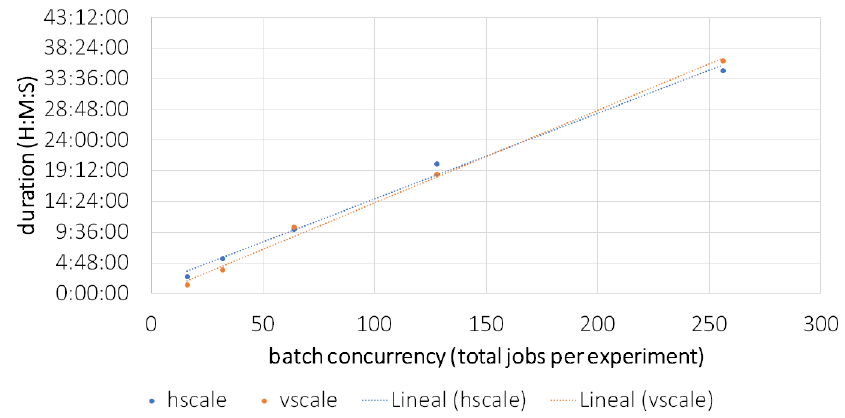
Figure 6. Transcoding batch duration (high CPU, high memory) vs. concurrency of jobs, represented for the two scaled clusters. It shows how the increase in memory is not so related to the calculation performance of each job, but rather to the reliability of the process.